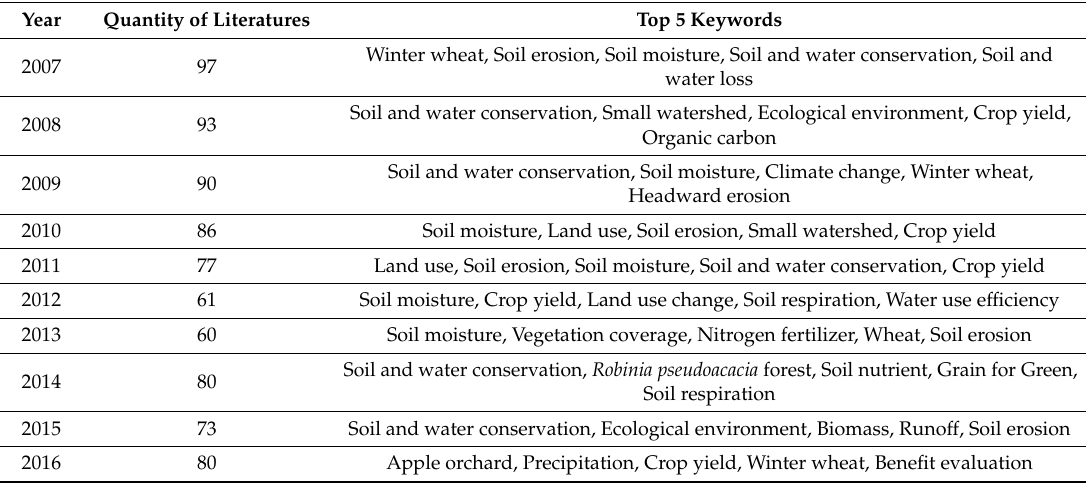
Table 3. Annual distribution of the main research topics of the CNKI literature from 2007–2016. Year Quantity of